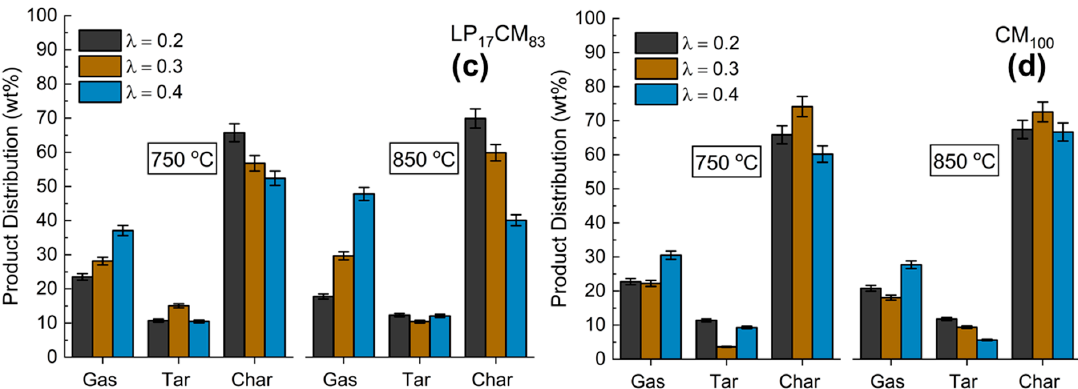
Figure 2. Product distribution of: ( a ) LP 100 , ( b ) LP 48 CM 52 , ( c ) LP 17 CM 83 and ( d ) CM 100 at two different gasification temperature parameters, 750 and 850 ° C. Air content in the flux is indicated by λ .